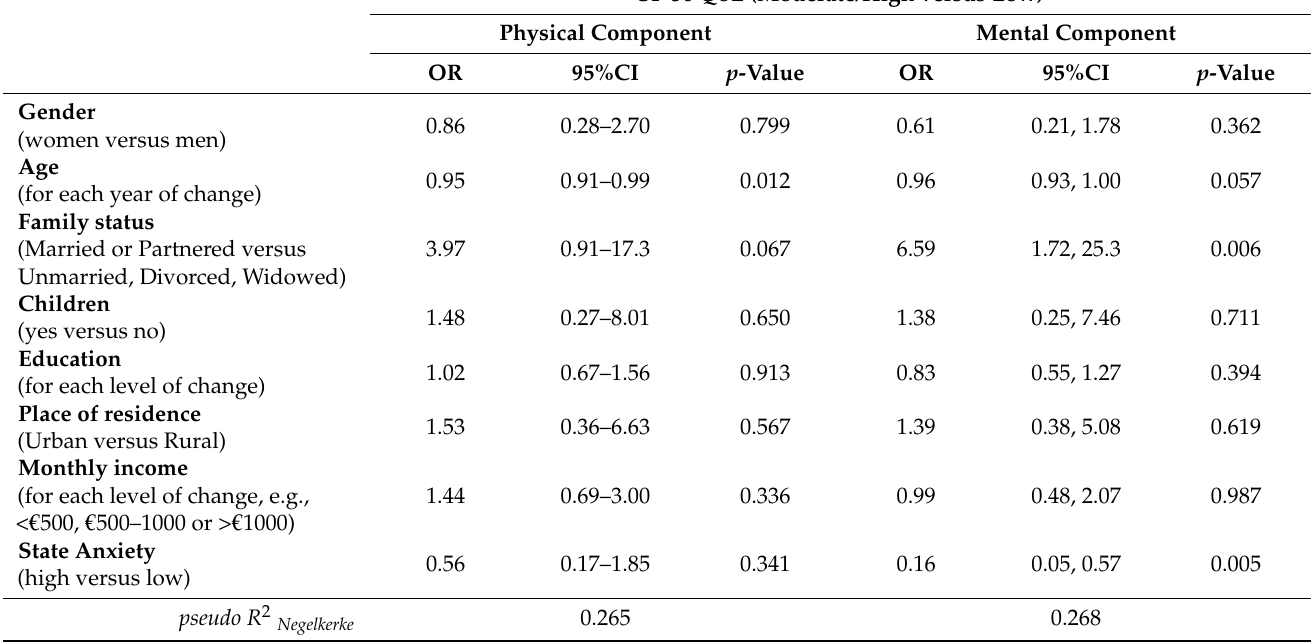
Table 4. Multiple logistic regression analysis of higher scores for Physical and Mental Components of QoL with patients’ characteristics and state